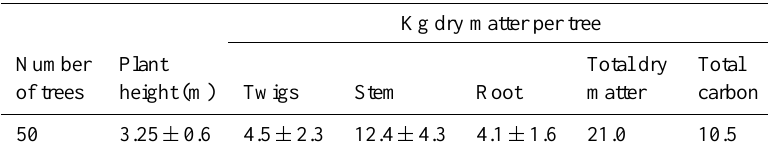
Table 1. Dry matter content and calculated carbon content of the twigs, stems and roots of 32 months old Jatropha curcas trees from a plantation in the desert of Luxor, Upper Egypt.